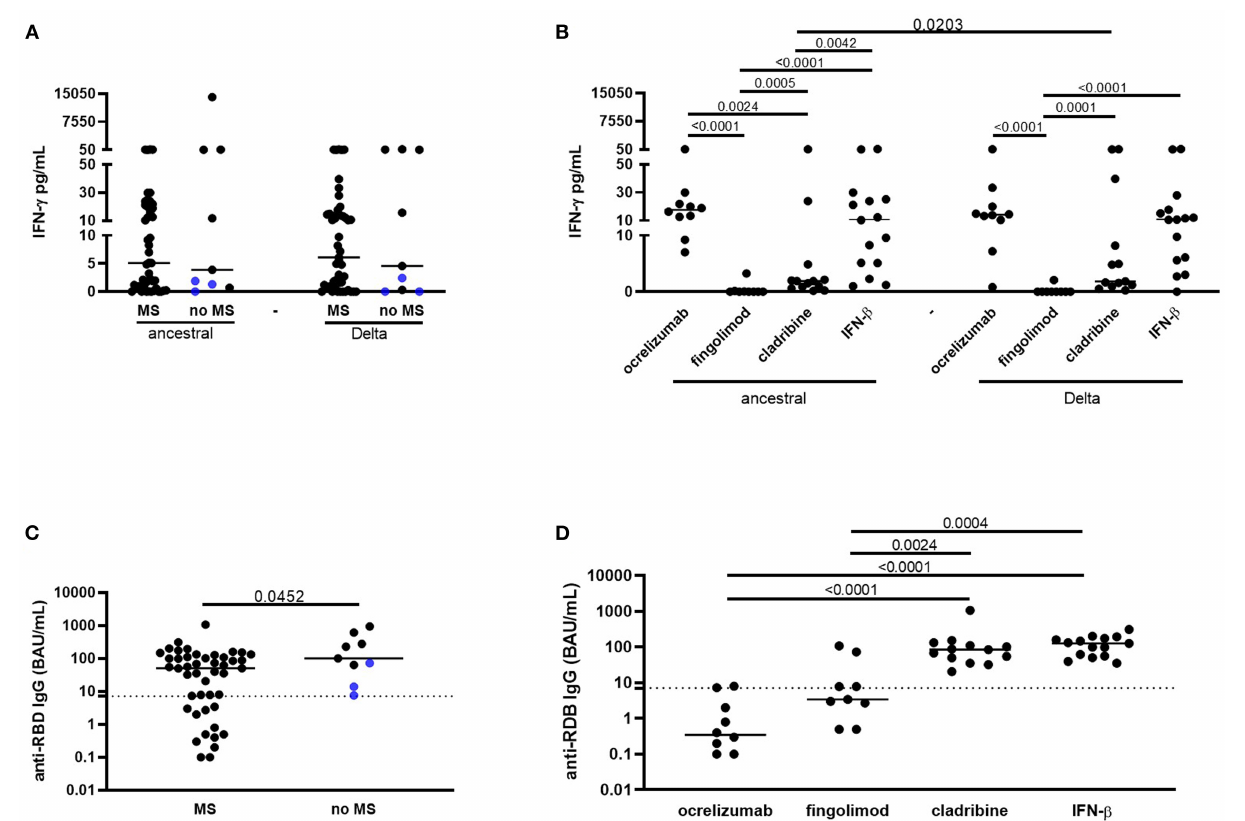
FIGURE 1 | Vaccinated patients with MS show a T-cell-specific response to spike from Delta SARS-CoV-2 variant and an anti-RBD IgG response similar to control subjects, although DMTs differently affect the responses. (A) No significant differences were found comparing the IFN- γ level between MS patients and “no MS” subjects in response to the ancestral or to Delta spike. The IFN- γ response to the ancestral peptide pool was similar to that observed in response to the Delta peptide pool in both patients with MS and in “no MS” subjects. (B) Patients with MS treated with fingolimod and cladribine showed a significant lower IFN- γ -specific response to both the ancestral or to the Delta pools compared to subjects treated with ocrelizumab, or IFN- β . (C) Patients with MS showed significant lower anti-RBD-IgG levels compared to “no MS” subjects. (D) MS patients treated with ocrelizumab or fingolimod had significant lower anti-RBD-IgG levels compared to patients treated with cladribine or IFN- β . Horizontal lines represent medians. Dotted lines represent ELISA IgG cut-off. IFN- γ levels were measured by ELLA, anti-RBD IgG were measured by ELISA. Mann–Whitney or Wilcoxon tests were used for pairwise comparisons. MS, multiple sclerosis; IFN, interferon; RBD, receptor binding domain; BAU, binding antibody